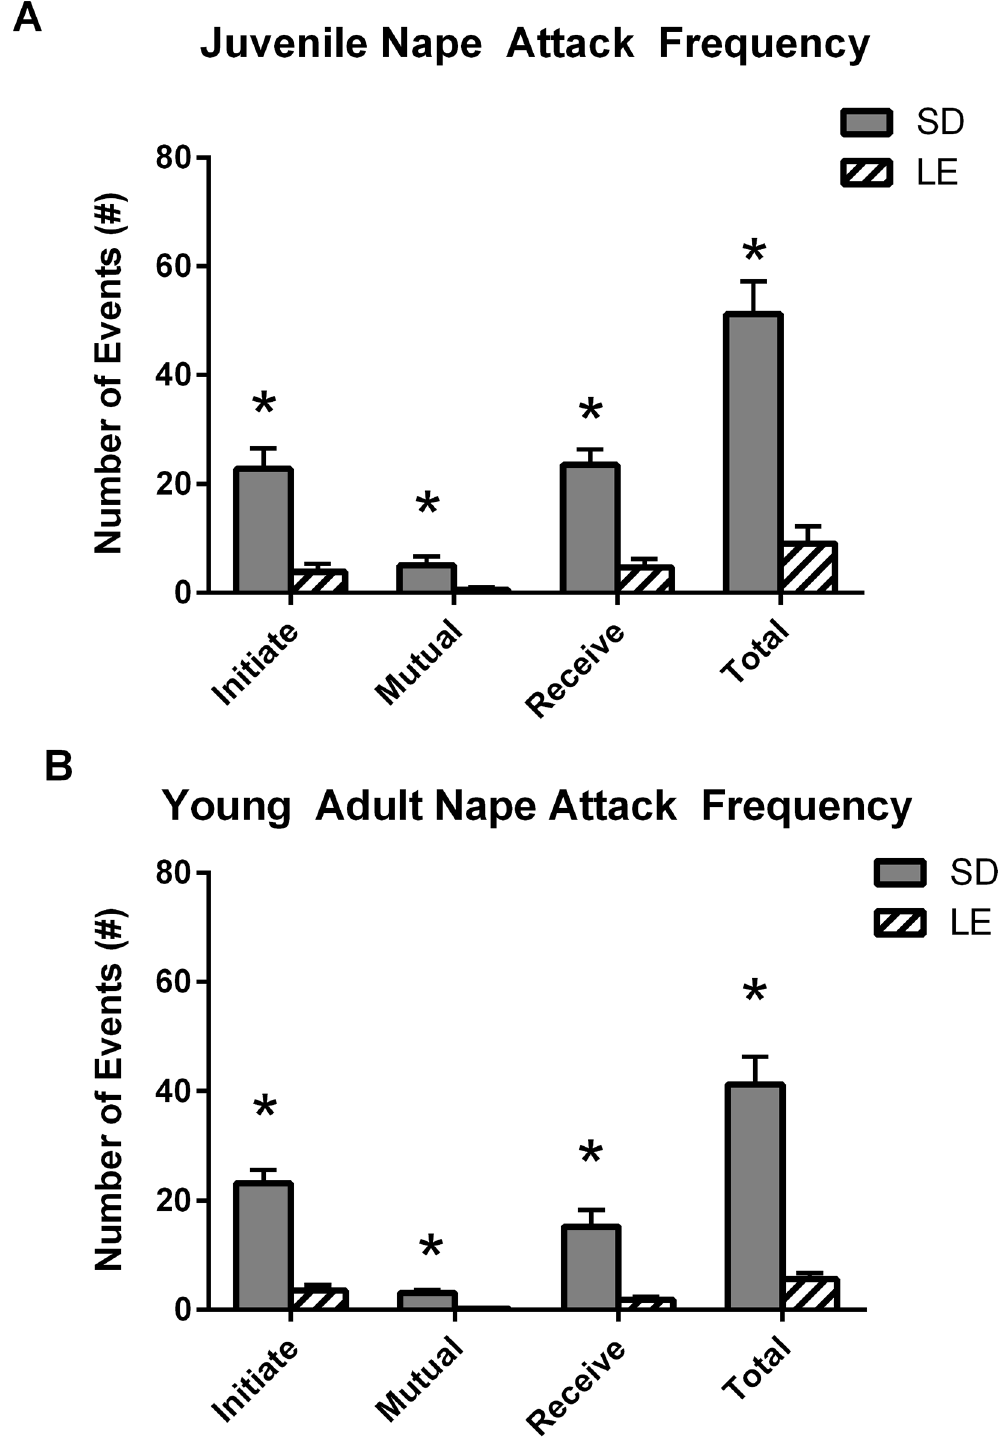
Fig 6. Significant strain differences in number of nape attacks at juvenile and young adult time points in SD and LE rats during a social dyad task. A) SD rats show significantly more social play behavior, expressed in nape attacks, than LE rats at ages PND 36 – 37 and B) at ages PND 55-56Data shown are mean (+SEM) for a 10 minute task.